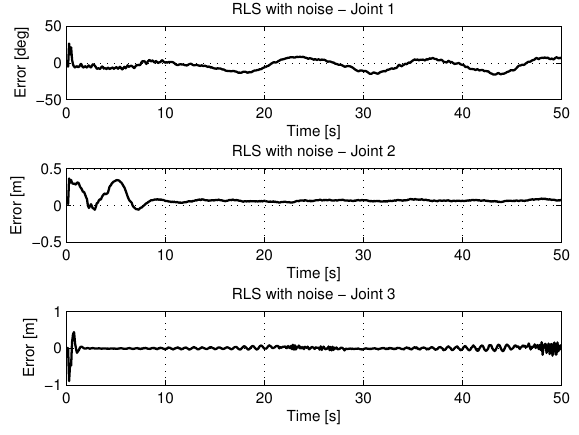
Figure 28. Error of Trajectories identifications with RLS with